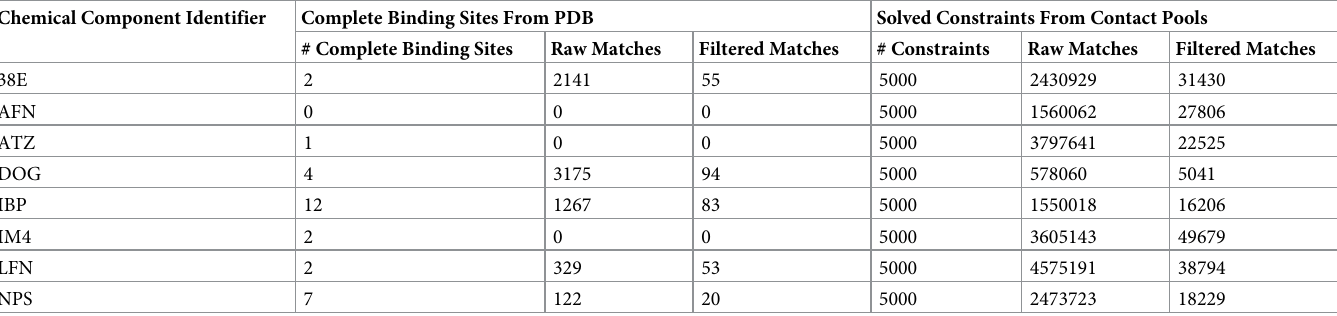
Filtered match counts constitute the 25 best-scoring matches that pass quality filters for each set of matches that result from constraints for a single composite binding site and place the same residue identities at the same positions in a scaffold